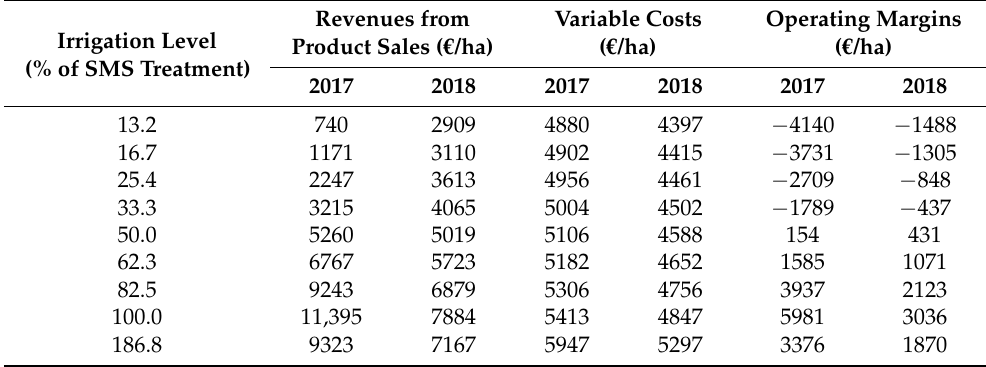
Table 4. Revenues, variable costs, and operating margins at the different levels of irrigation in 2017 and 2018 tomato growing